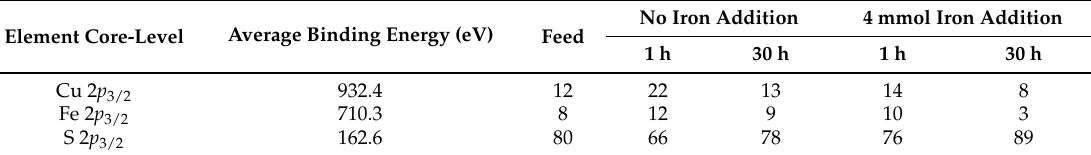
Table 3. XPS elemental quantification (at.%) for the feed chalcopyrite and chalcopyrite leached at 750 mV, 75 ˝ C and pH 1.0.